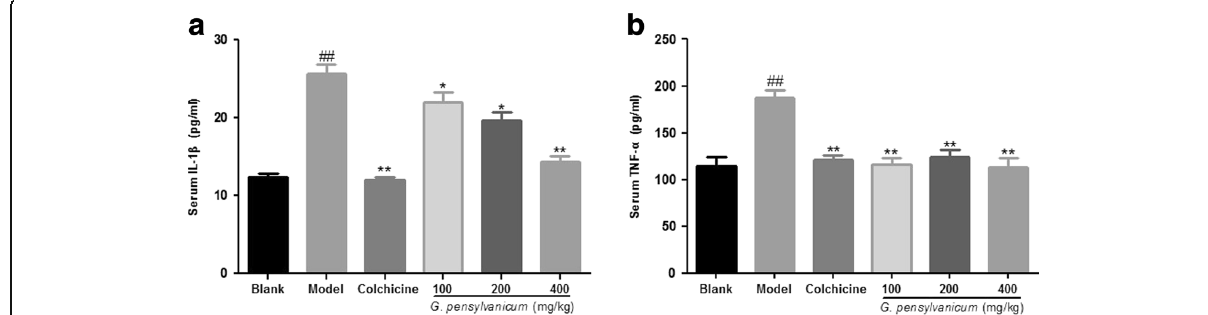
Fig. 7 Effects of G. pensylvanicum and colchicine on the levels of IL-1 β ( a ), and TNF- α ( b ) in the serum were measured 24 h after hypodermic injection of MSU crystals. Results were shown as mean ± SEM ( n = 10). ## p < 0.01 vs. Blank group; * p < 0.05, ** p < 0.01 vs. Model